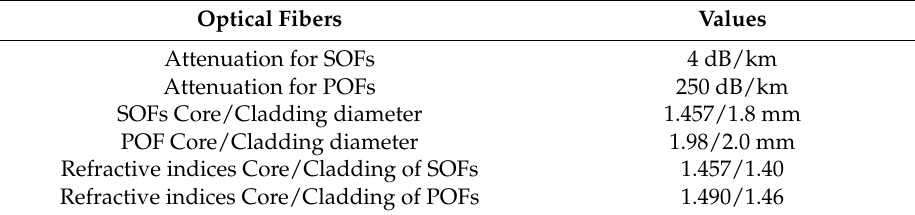
Table 2. The parameters of the SOFs and POFs technical